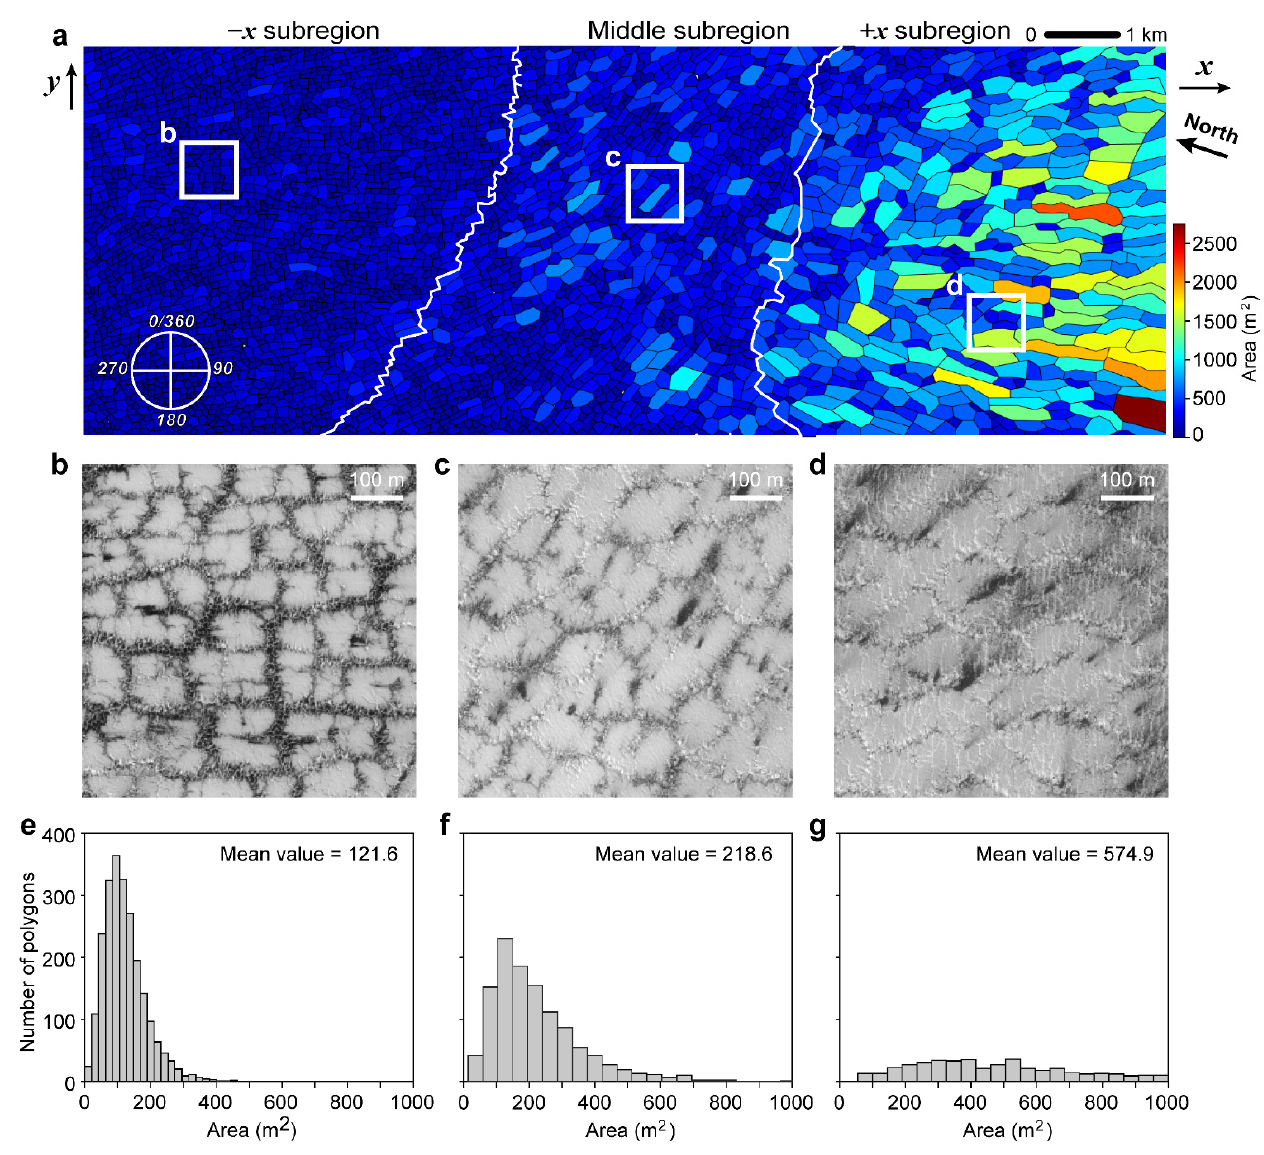
Figure 3. The analysis of polygon areas. ( a ) Distribution of the polygon areas. The entire region is divided into three subregions (– x , middle, and + x subregions), approximately separated by the boundaries of the individual polygons (the white lines). ( b – d ) Three representative enlarged HiRISE images of the polygonal terrains in the subregions, where their locations are marked in ( a ). ( e – g ) Histograms showing the number of different area polygon areas in the three subregions. The mean values of the areas are marked.